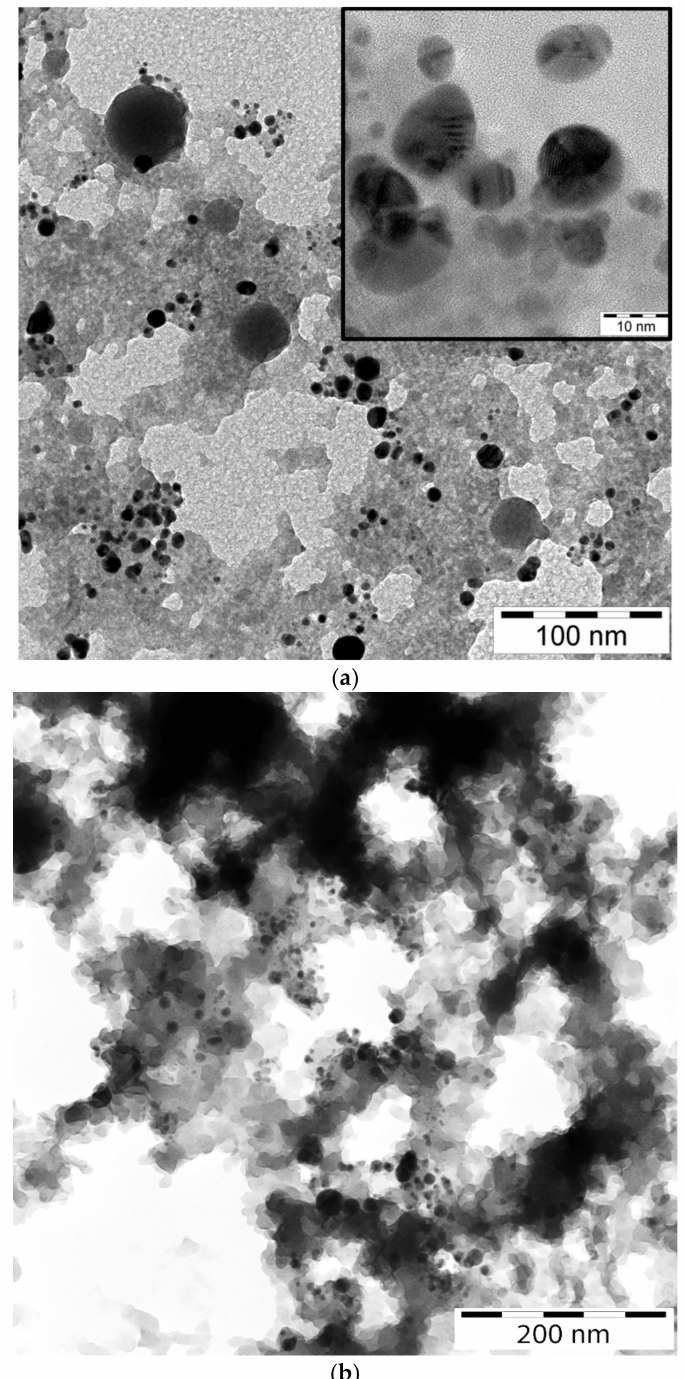
TEM images of nanocomposite NPs BTO-Au synthesized by the two approaches are presented in Figure 9. Au NPs are visible due to their higher contrast compared to BTO NPs. Au NPs are on average 10 nm in diameter in case of ablation of Au target in BTO NPs colloidal solution. Relatively large spherical NPs of BTO are also visible.